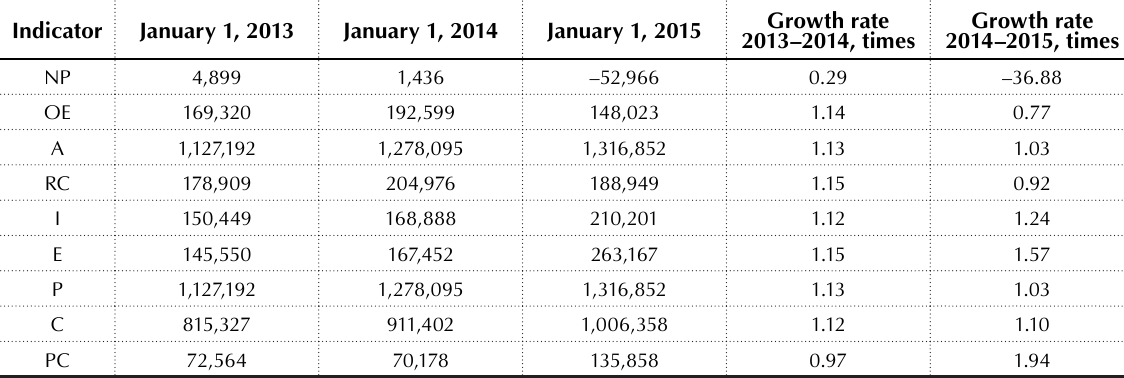
Table 3. Input statistic data of the Ukrainian banking system, 2013–2015, in UAH